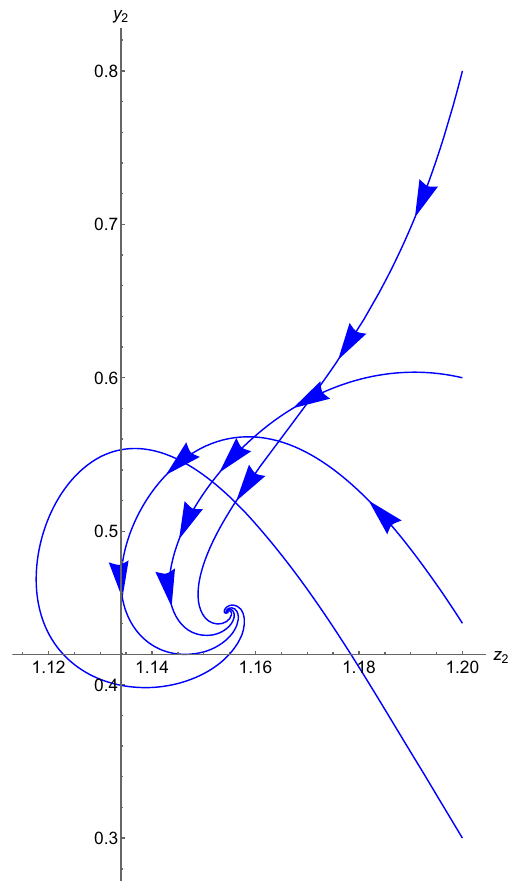
Fig. 5 The evolution towards the critical point P 6 + ( α 1 = 10 ,α 2 = 12 ,ξ 1 = 0 . 2 ,ξ 2 = − 0 . 1 ,w m = 0)